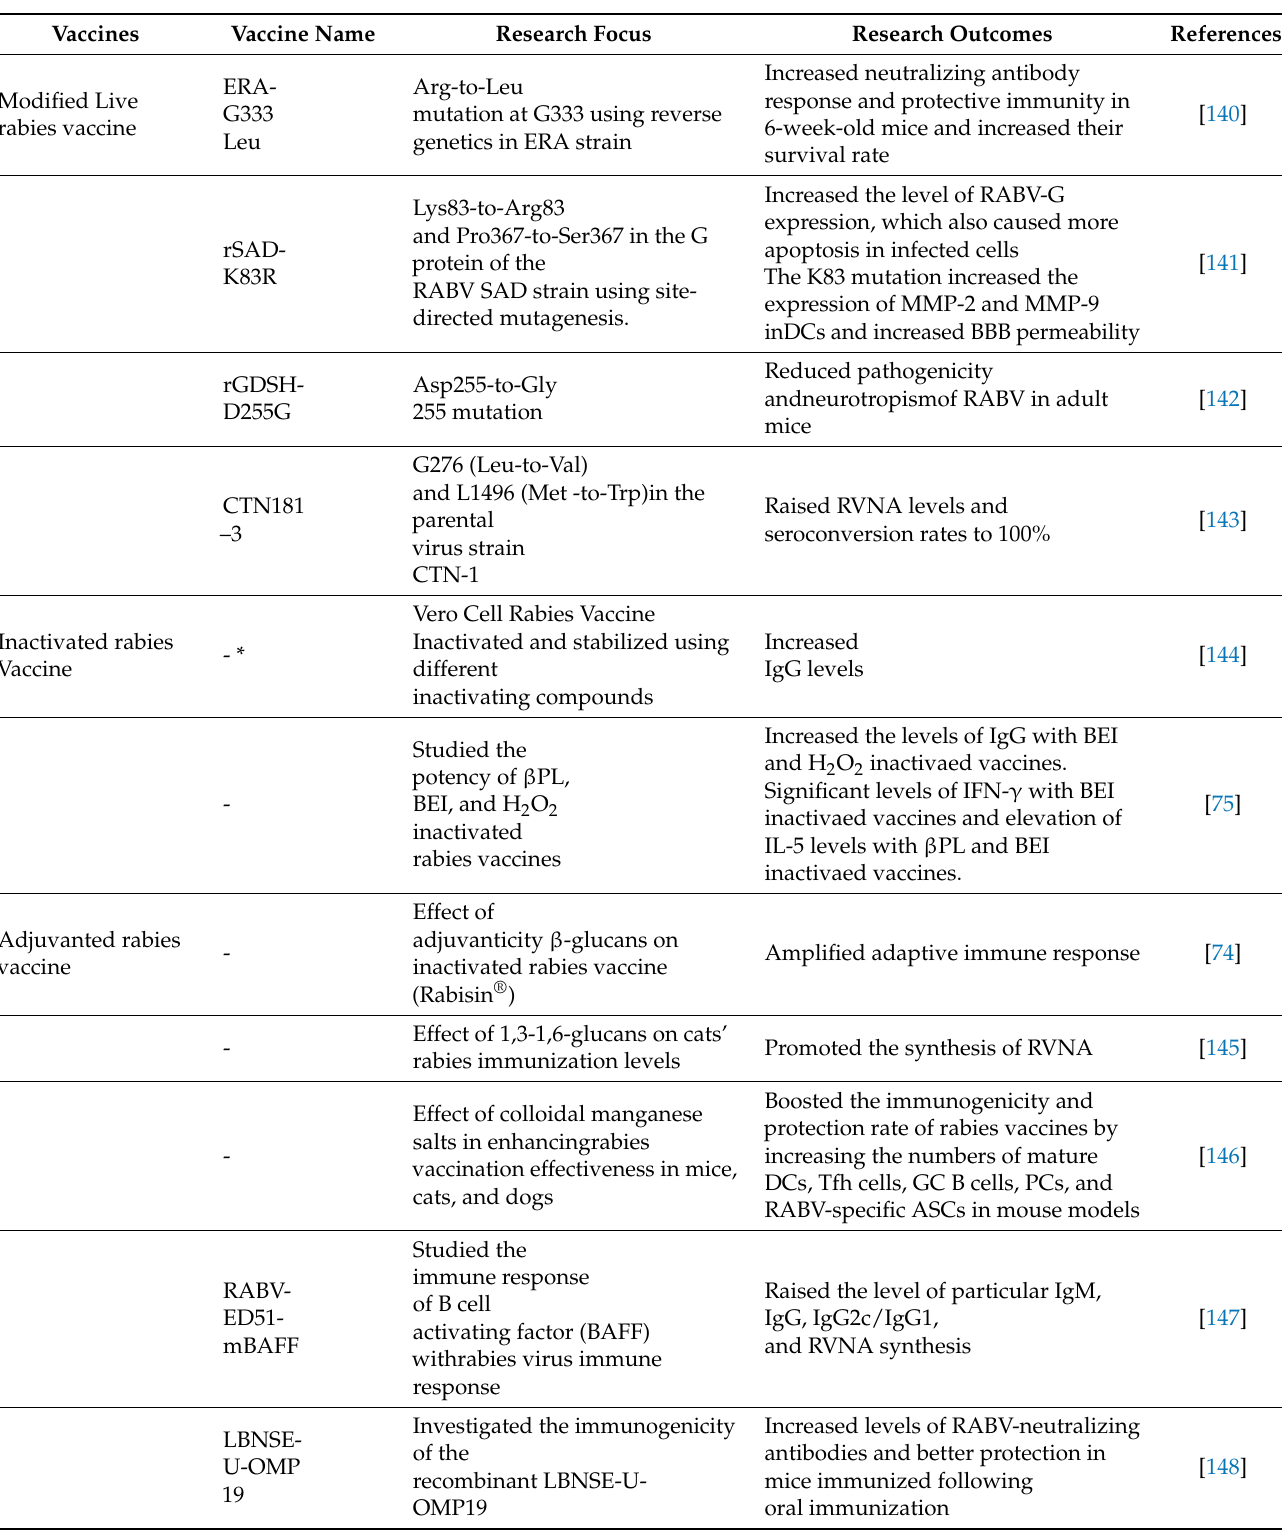
Table 1. Current research status of rabies